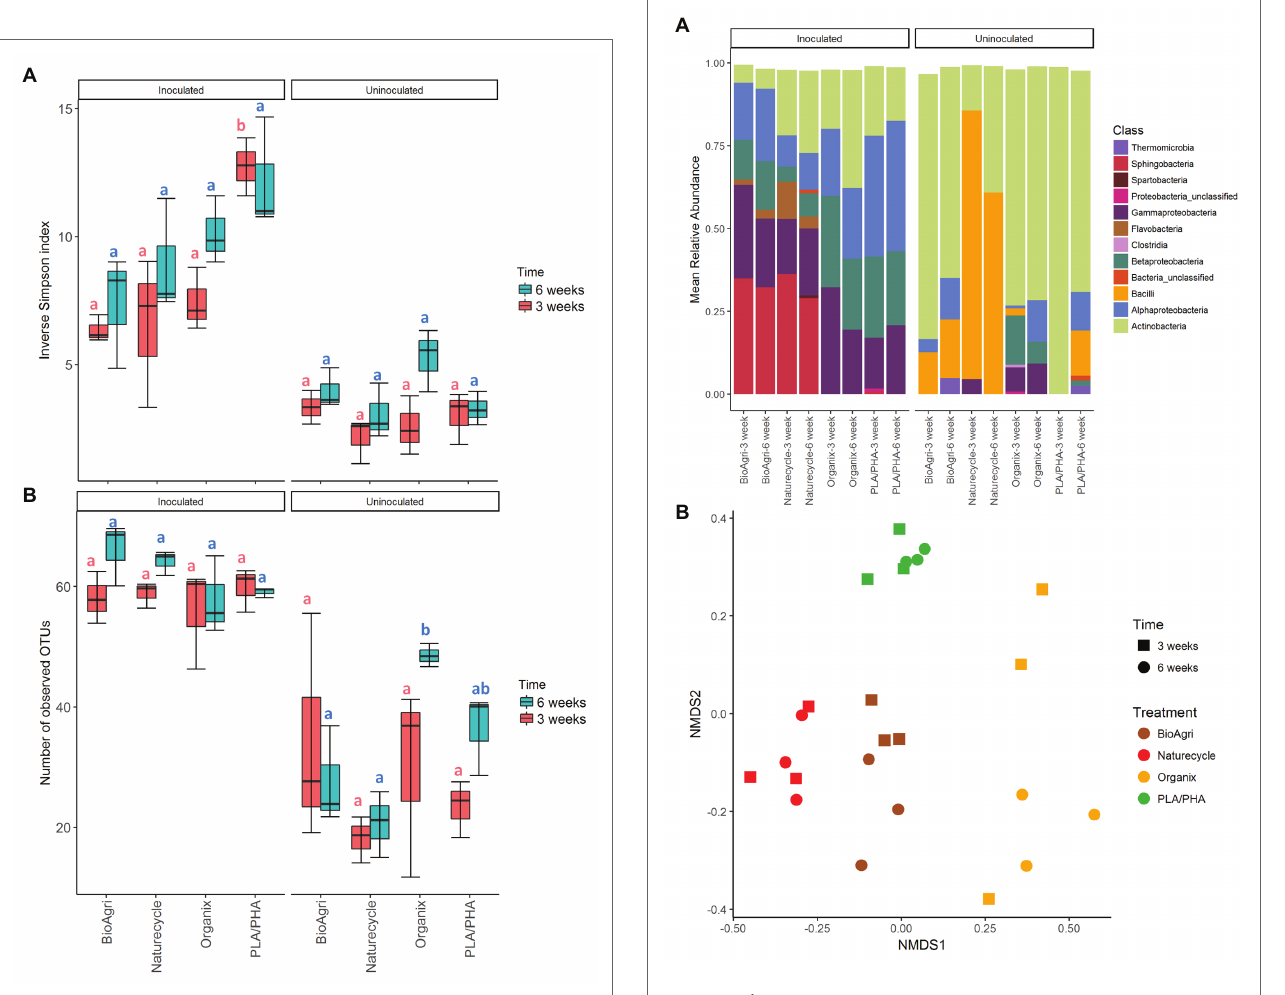
FIGURE 2 | (A) Diversity (inverse Simpson index) and (B) richness [number of observed operational taxonomic unit (OTU)] for bacterial communities in inoculated and uninoculated enrichments. The lower and upper hinges of the boxplots correspond to the 25th and 75th percentiles and the middle of the box denotes the median at 50th percentile. Whiskers denote 1.5 times the inter-quartile range. Letters indicate Tukey post hoc results following a one- way ANOVA. All significances tested at α =